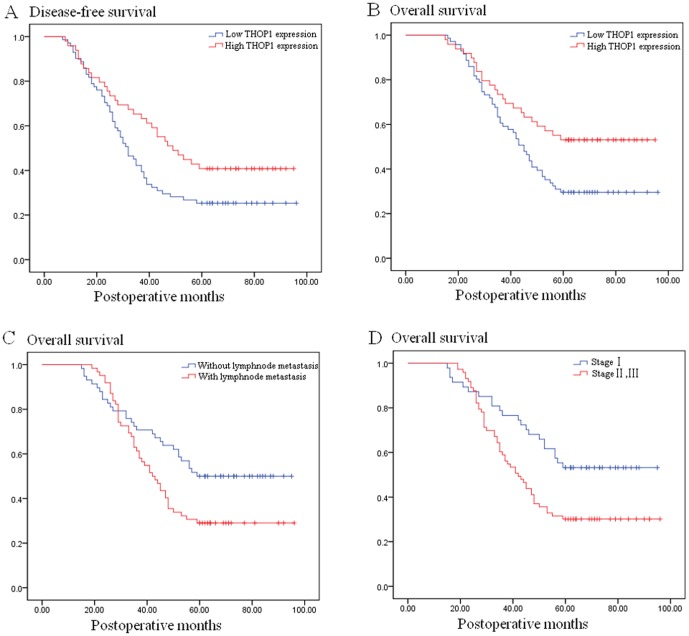
Kaplan–Meier curves of disease-free and overall survival stratified according to THOP1 protein, lymph node metastasis and TNM stage.